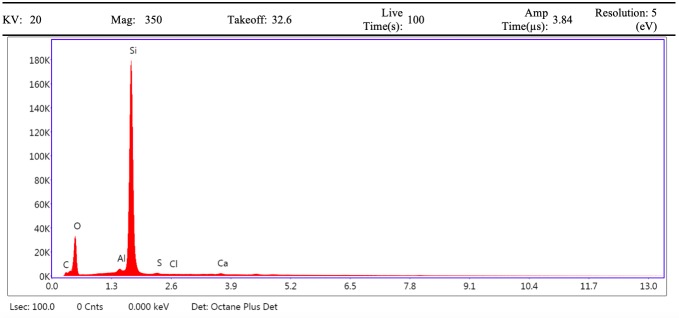
EDS spectrum of mineral grain from demineralised Late Cretaceous Centrosaurus bone area A.